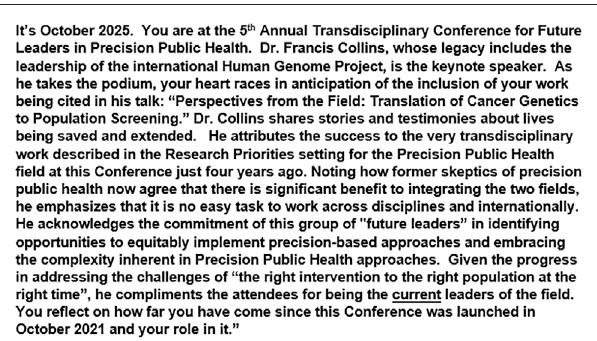
FIGURE 1 | Envisioning success scenario from workshop session